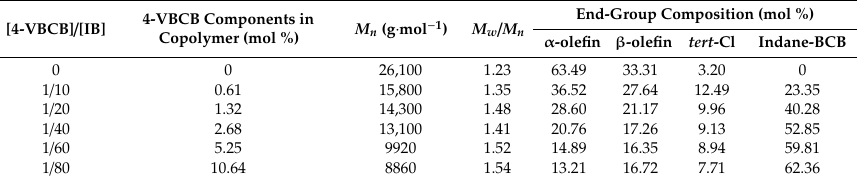
Figure 4. 1 H NMR spectra of the copolymer end group. Table 3. End group composition of different 4-VBCB feed quantities.